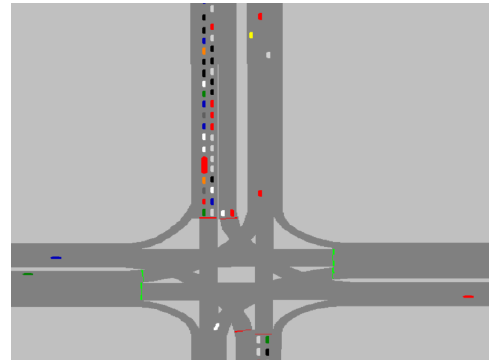
Figure 12. Congestion Scenarios.